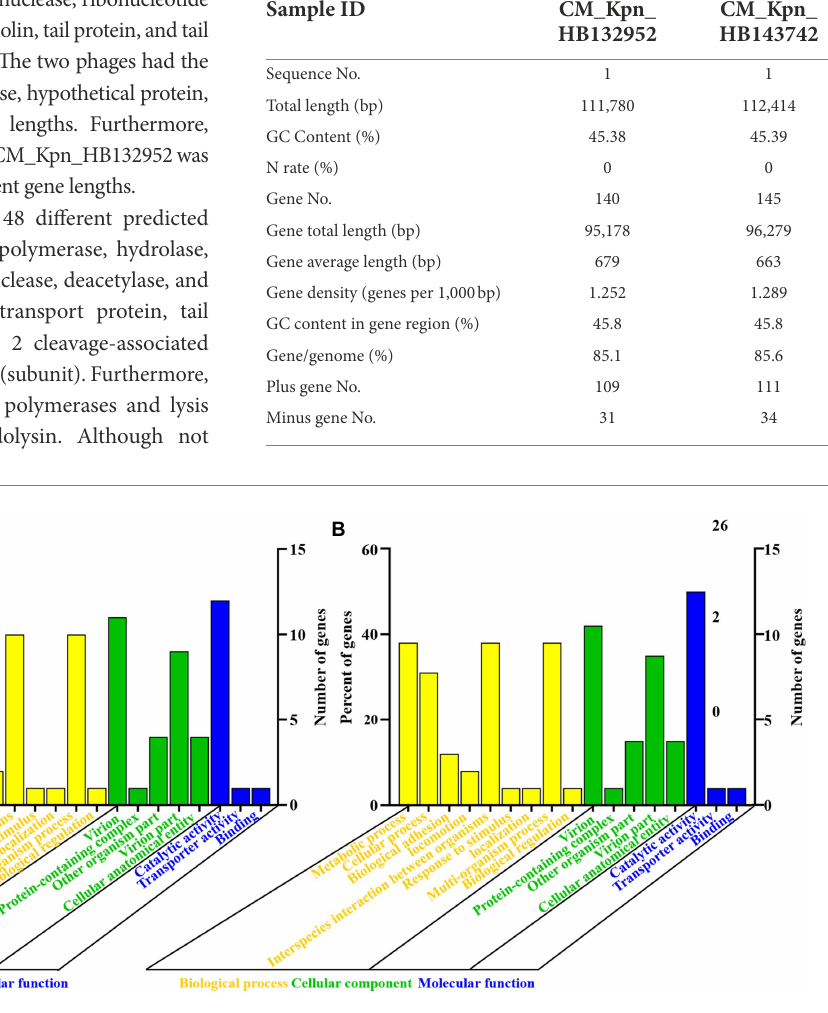
FIGURE 5 Gene ontology functional annotation of phages. (A,B) Gene ontology (GO) analysis of phage CM_Kpn_HB132952 and CM_Kpn_HB143742, respectively. Based on GO functional annotation, phage CM_Kpn_HB132952 had a total of 25 genes and CM_Kpn_HB143742 had a total of 26